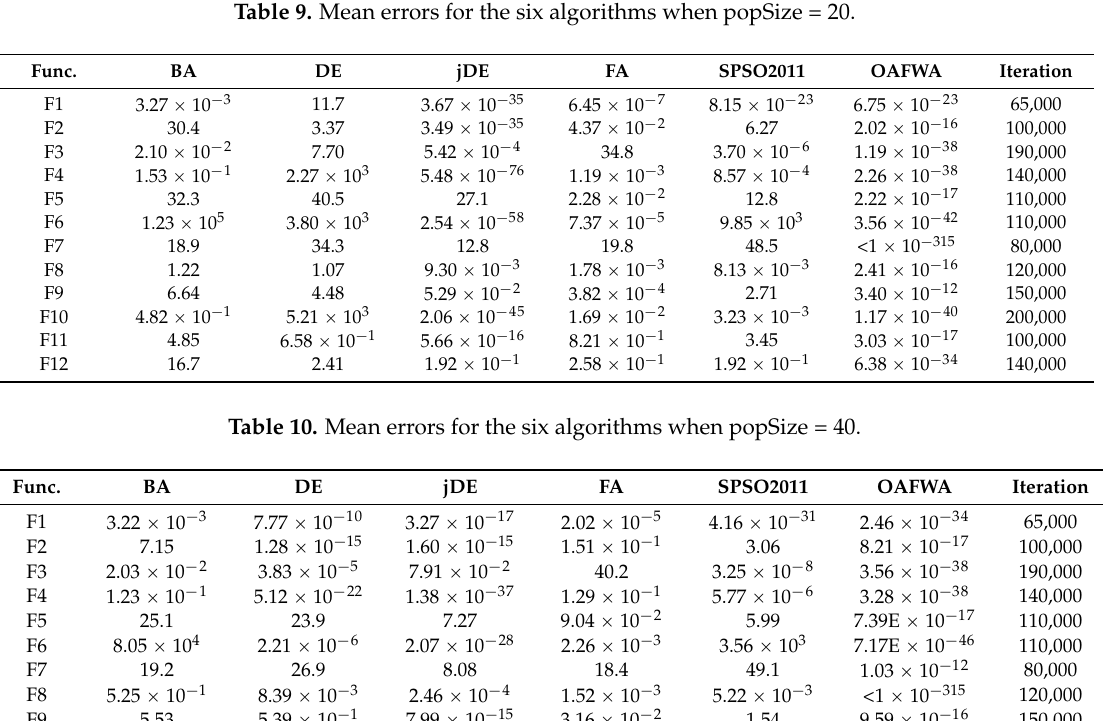
Table 9. Mean errors for the six algorithms when popSize = 20.